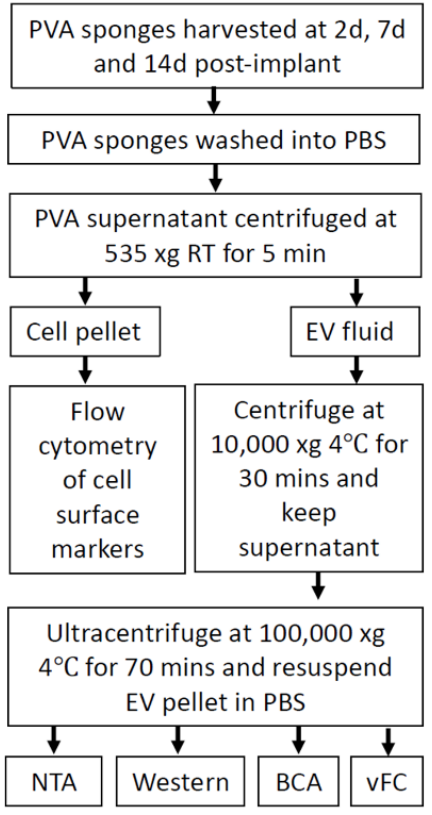
Figure 4. Overview of enrichment of extracellular vesicles released in PVA sponge implants. Wound fluid harvested from PVA sponges was used for analysis of cells and EVs by serial centrif- ugation.